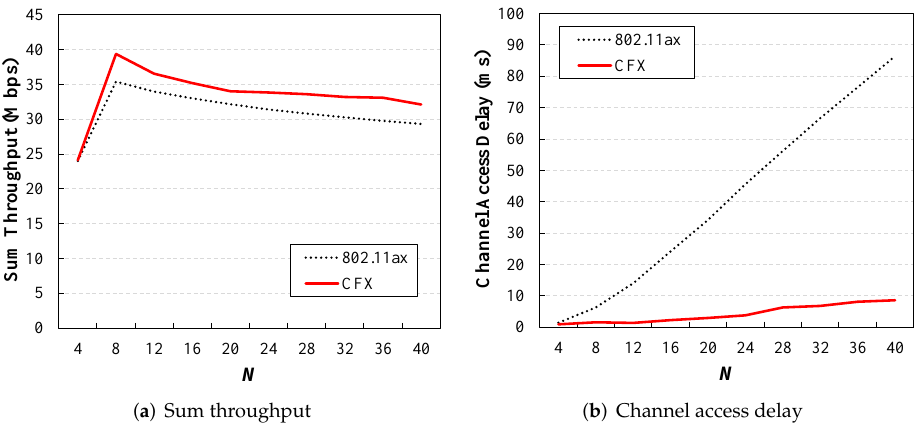
Figure 9. Performance of CFX in homogeneous networks. The users obtained about 4 Mbps more throughput in CFX on average than in the legacy 802.11ax mode ( a ), and at the same time, the channel access delay was reduced to 10 ms from 85 ms when the number of users was 40 ( b